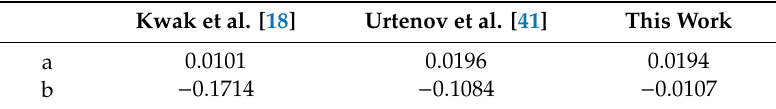
Table 2. Parameter values of the correlation δ v / L m = a published values. 3rd columns: this work.